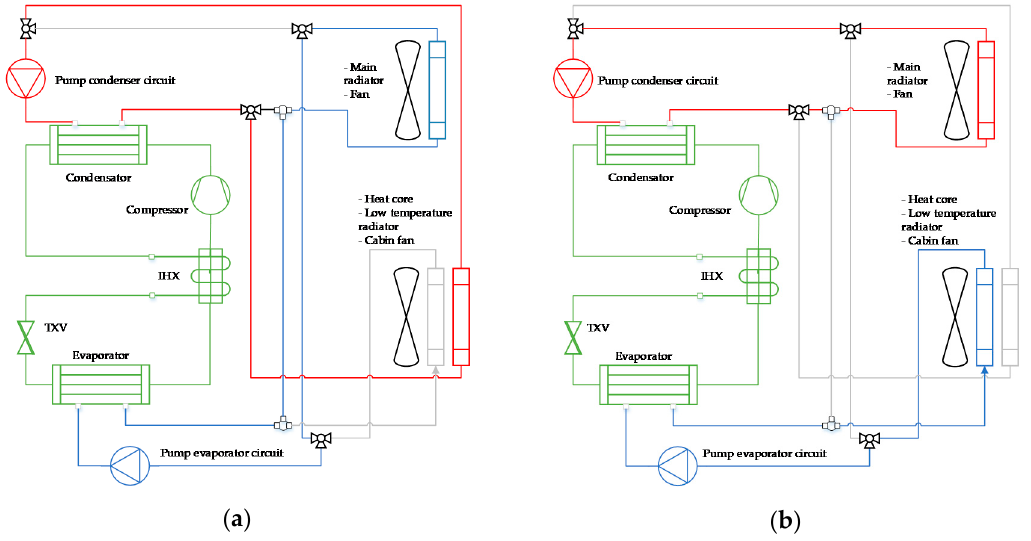
Figure 6. Case study HVAC system model in: ( a ) heating mode; and ( b ) cooling mode.